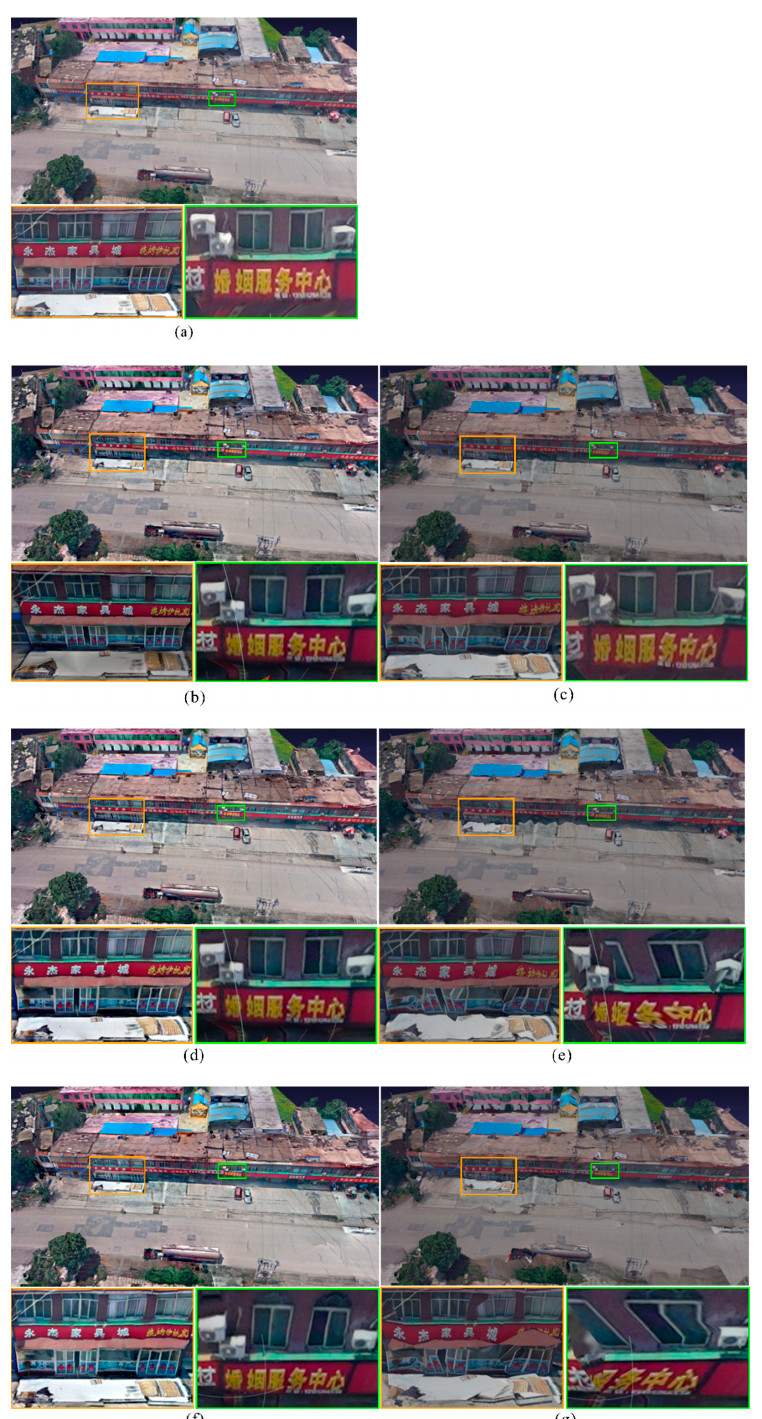
Figure 11. Texture quality comparison of the building area models. The orange and green framework in the upper overall image represent the corresponding local enlarged drawing below the overall image. ( a ) Original mesh (true value): α = 1.0, β = 1.0, number of facets = 109,304. ( b ) The